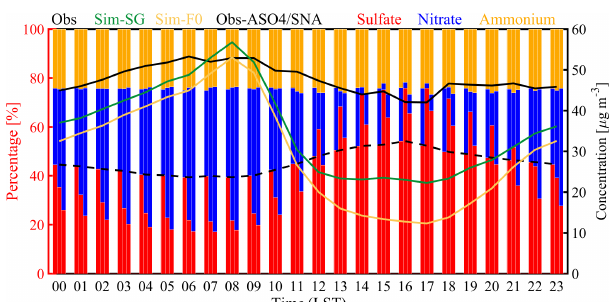
Figure 6. Averaged diurnal variation for the observed and simulated total SNA concentrations (solid lines), observed ASO4/SNA ratio (black dashed line), and the percentage of sulfate, nitrate and am- monium in total SNA concentrations (color bars, i.e., observations, simulations of SG and F0) in Wuhan, 1–21 October